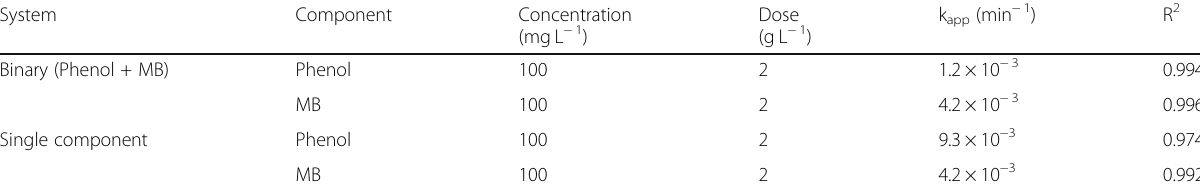
Table 2 The pseudo-first-order rate constants of competitive oxidation of phenol and MB by Photo-Zn-Bent hybrid in single and binary component system System